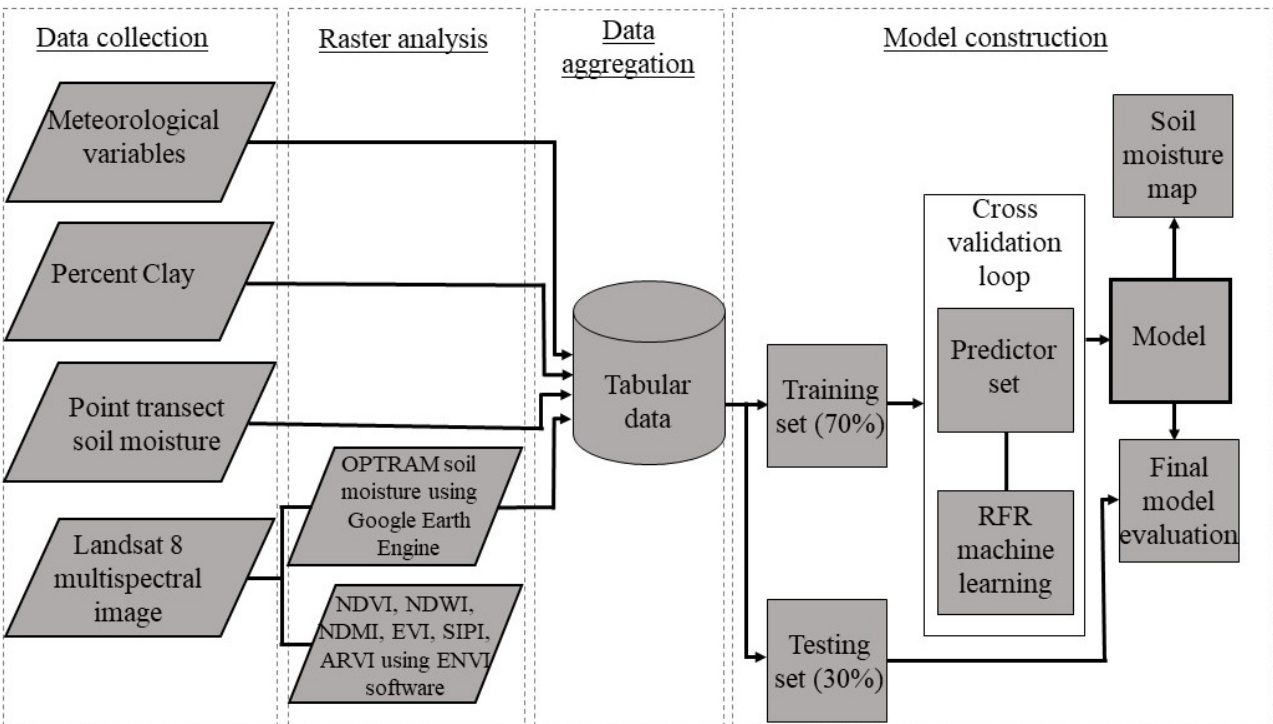
Figure 3. Flow chart showing the Landsat 8 image processing and SM prediction model using Random forest regression (RFR) algorithm. Random forest regression (RFR)